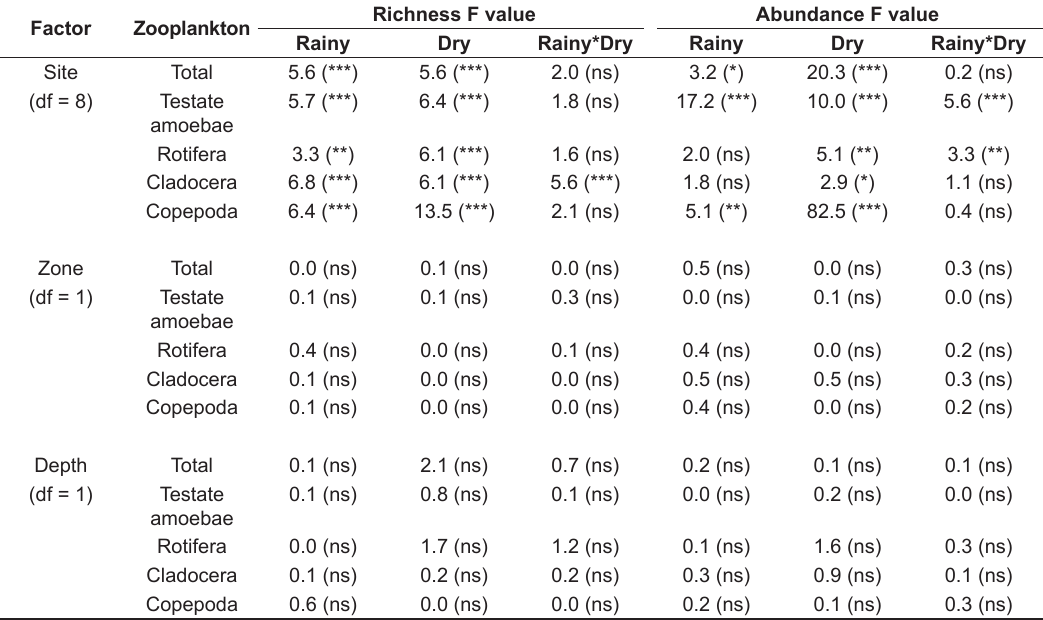
Table 3. Analysis of variance (ANOVA) of zooplankton richness and abundance by sites (1-9), zones (littoral and channel), and depths (surface and bottom) within and between the hydrological seasons (rainy and